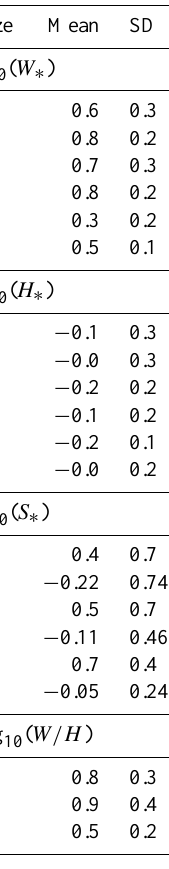
Table 4. Mean and standard deviations of the logarithms of de- trended widths, depths and slopes. The aspect ratios is naturally detrended and does not depend on grain